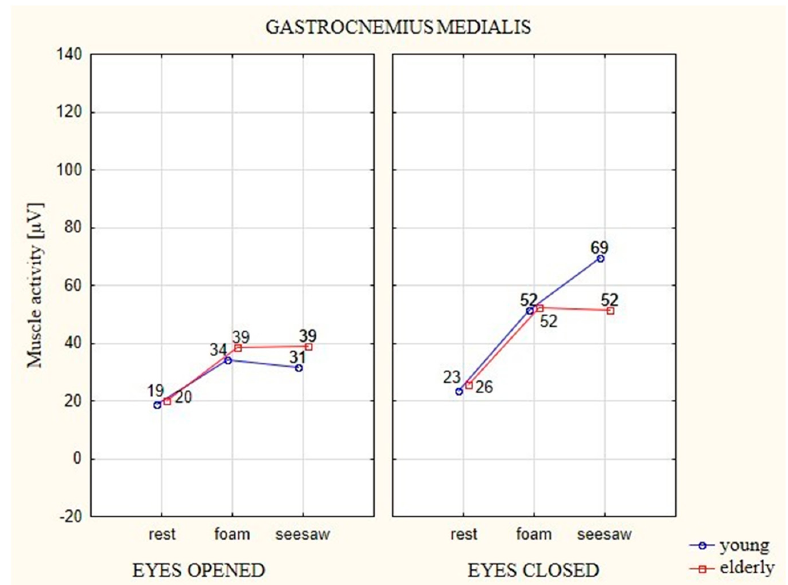
Figure 7. The average EMG values of the muscle GM in elderly and young participants on di ff erent types of surfaces and with EO (eyes 1) and EC (eyes 2).